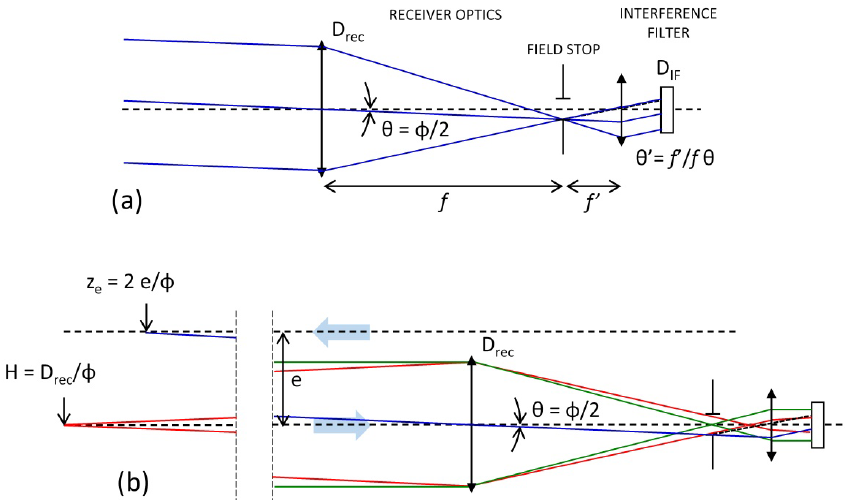
Figure 1. (a) Definition of useful parameters for field angle θ and filter angle of incidence θ (cid:48) calculations. f : receiver focal length; D rec : receiver diameter; φ : full lidar field of view; f (cid:48) : collimation focal length; D IF : IF diameter. (b) Definition of metrics for overlap calculations. e : emitter–receiver separation; H : hyperfocal distance; z e : entry distance of laser into field of view. Green, red, and blue lines represent rays from infinity, finite distance, and offset emitted beams,